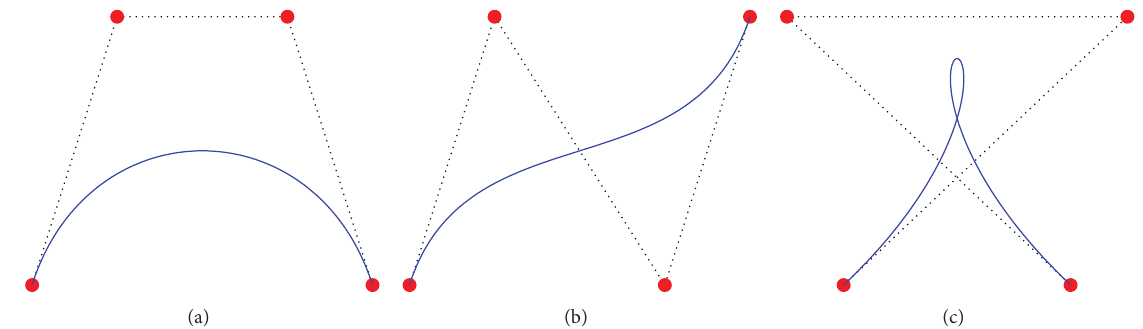
Figure 7: Effect of the derivatives (at the end points) on the shape of the curve: (a) simple curve; (b) twisted curve; (c) loop curve.